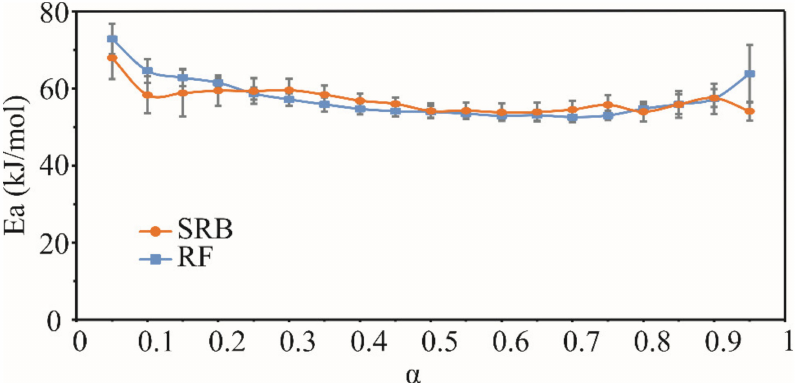
Figure 2. Activation energies (Ea) of the evaporation process of Russian (RF) and Serbian (SRB) rosemary essential oils as a function of conversion degree ( α